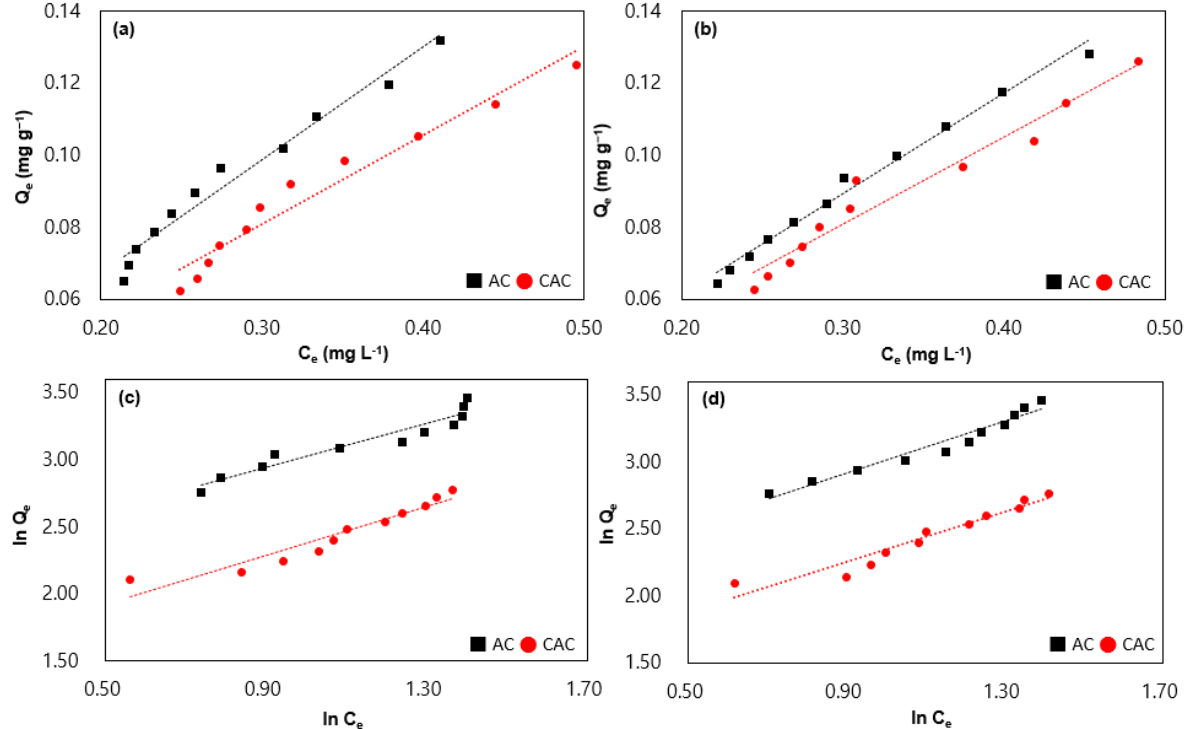
Figure 3. Langmuir isotherm of samples by various concentrations of toluene and benzene is depicted in ( a , b ), while Freundlich isotherm of the former ( c , d ). Table 4. Langmuir and Freundlich constants of samples by various concentrations of toluene and benzene.